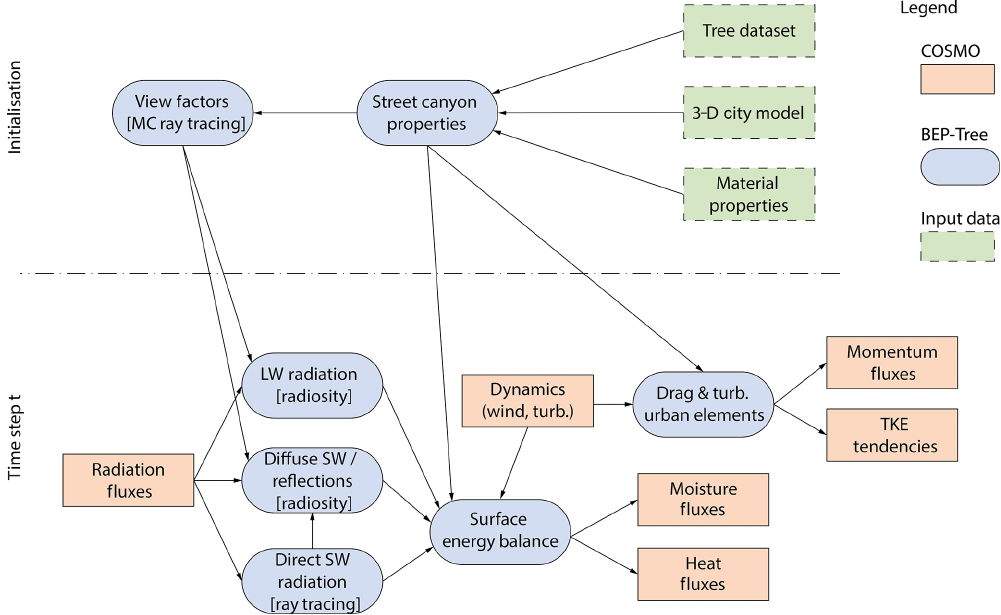
Figure 2. Flowchart of the coupling of BEP-Tree with COSMO. Rose-coloured boxes denote quantities of COSMO and blue-coloured boxes of BEP-Tree. Additional input datasets required to run COSMO-BEP-Tree are shown as green-coloured